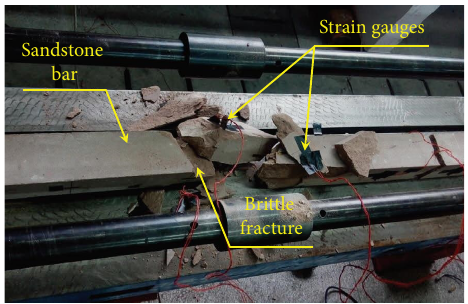
Figure 3: Critical instability of sandstone